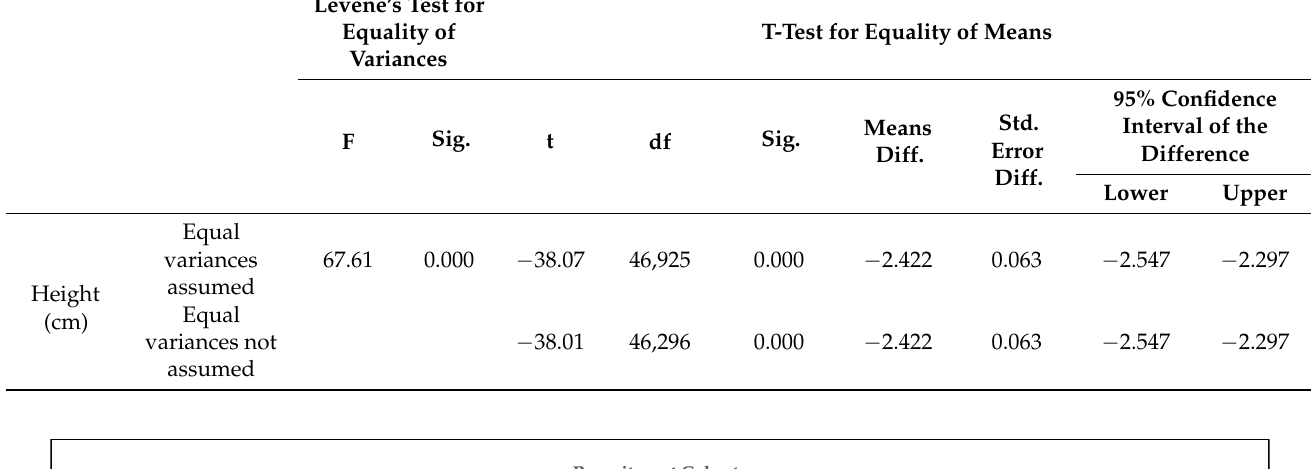
greater presence of agrarian workers in villages and small towns, but also with the lower presence of wealthy families in them. Levene’s Test for Table 3. T-test for equality of means in the sample Extremadura (agrarian and non-agrarian workers). Equality of